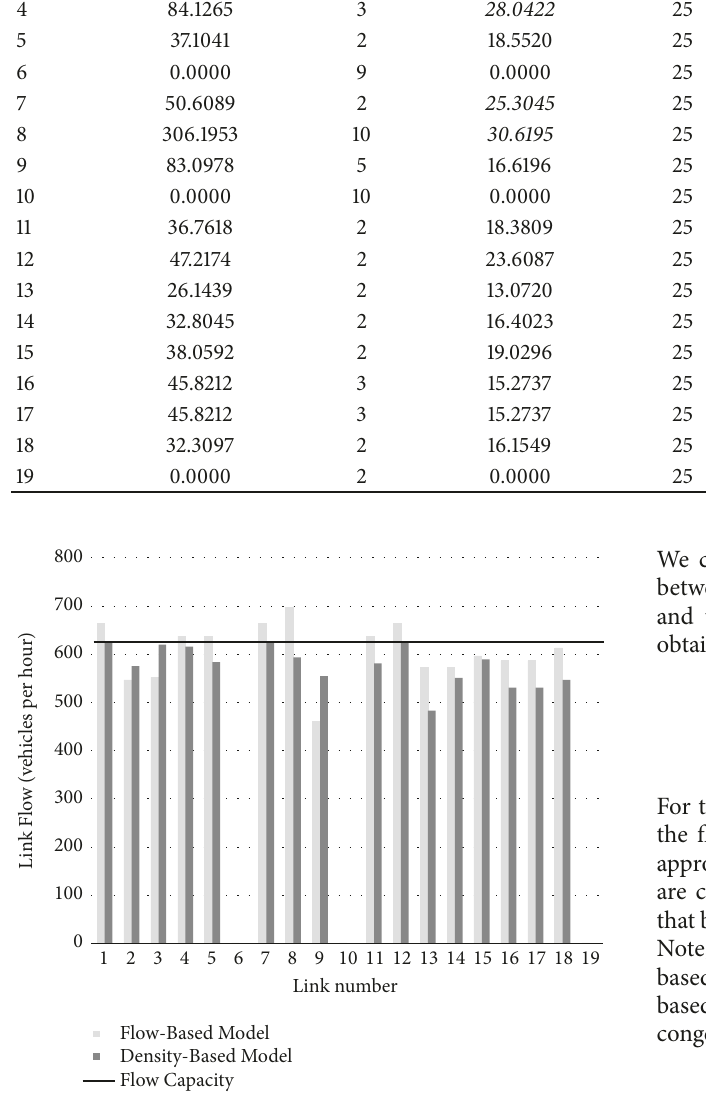
Figure 7: Link Flows, Both Approaches (high